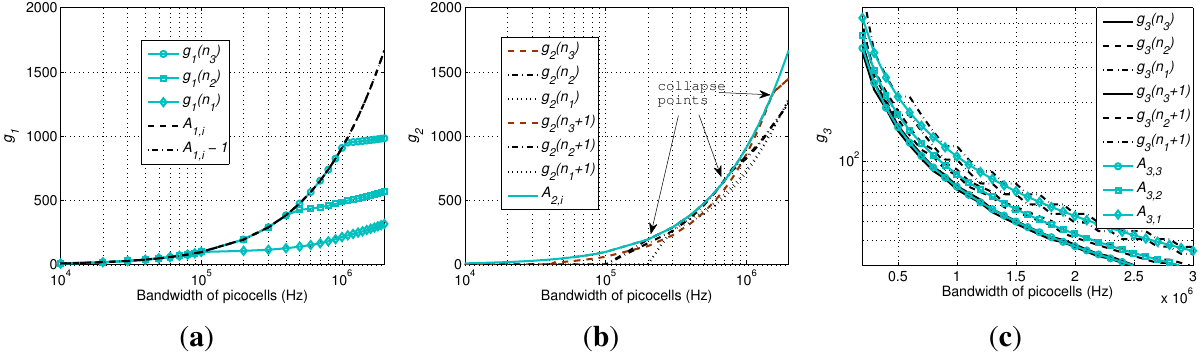
Figure 5. Verification of the theorems. ( a ) Theorem 1; ( b ) Theorem 2; ( c ) Theorem